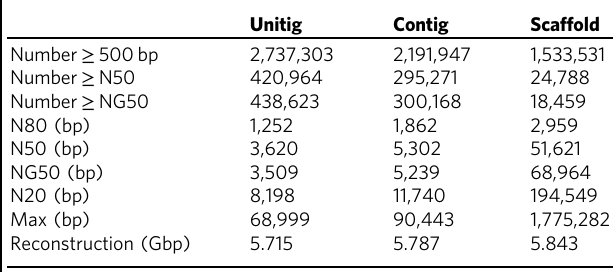
Table 1 Assembly statistics for sequences 500 bp or more